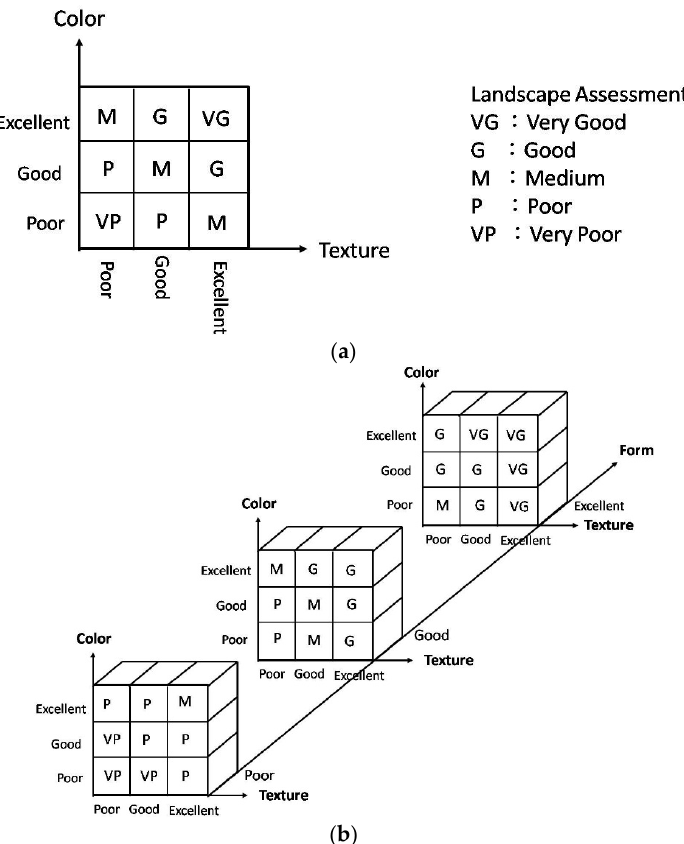
Figure 4. Setup rules for a fuzzy logical system: ( a ) presented with square FAM; ( b ) presented with cubic FAM and hierarchic cubic FAM.